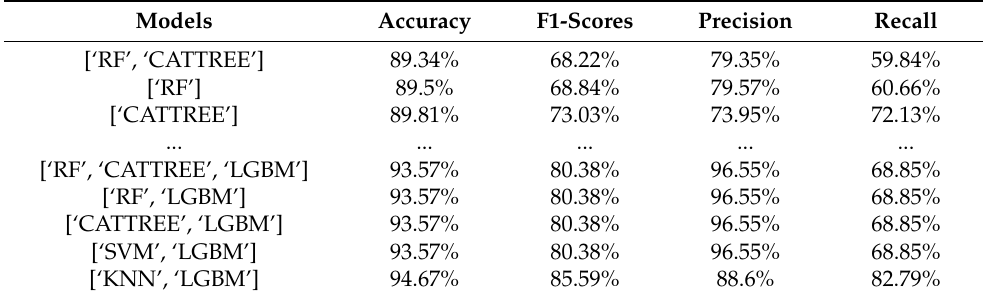
Table 3. Comparison of different combinations on